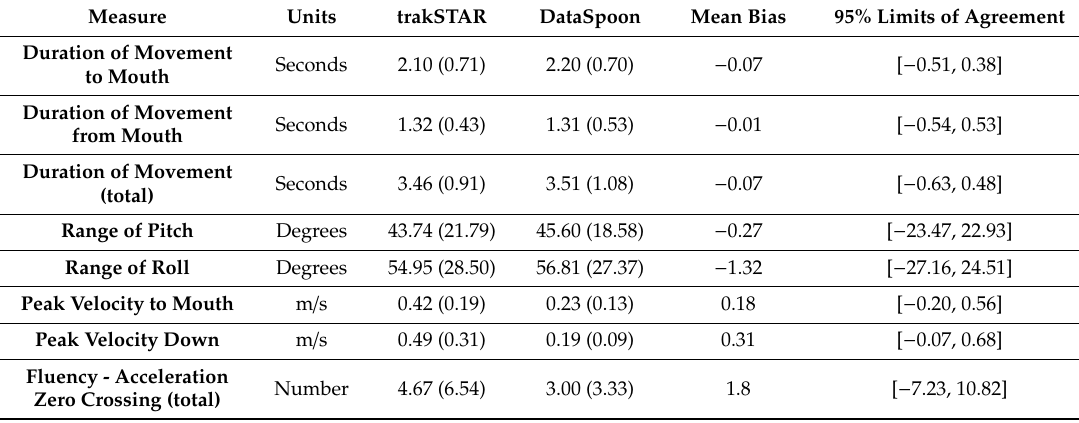
Table 3. Median and IQR values for the di ff erent kinematic measures for trakSTAR and DataSpoon, mean di ff erence (bias) and 95% limits of agreement ( ± 1.96 standard deviations) between trakSTAR and DataSpoon